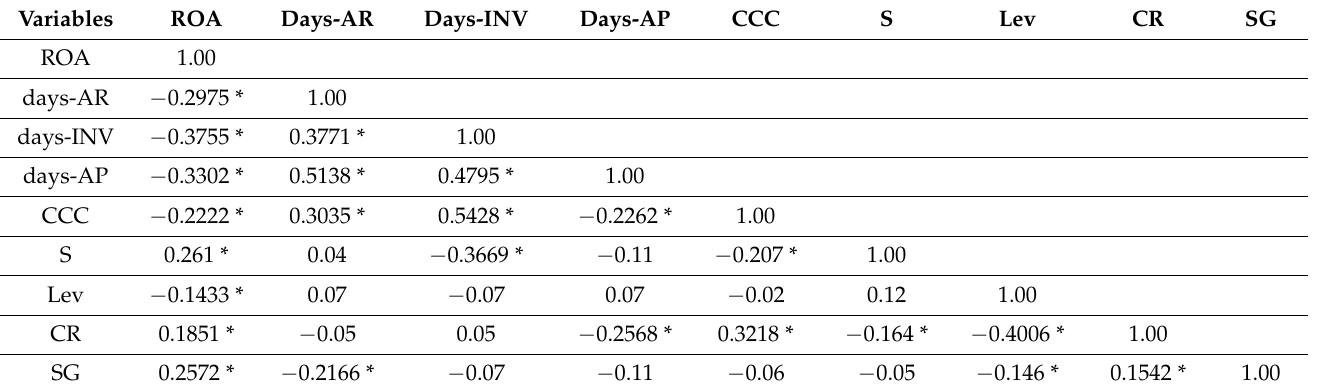
Table 5. The correlation amongst the variables—pandemic period